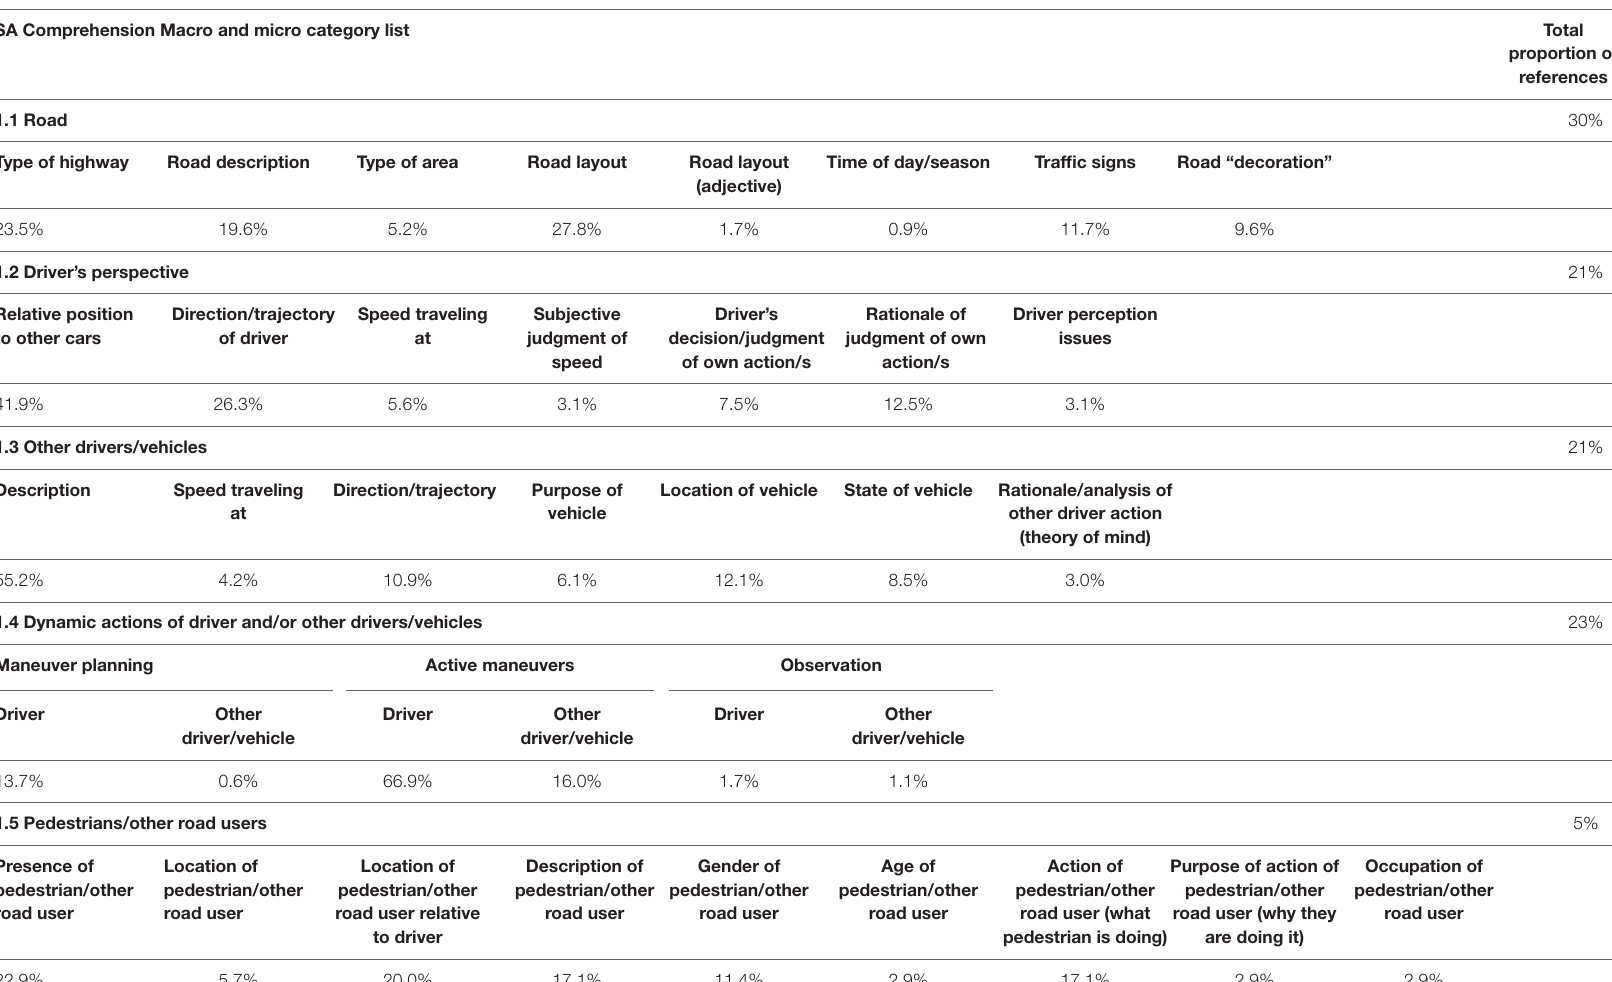
TABLE 4 | Total proportion of references to each theme and the frequency (%) at which each of the sub-themes were referenced within each theme. SA Comprehension Macro and micro category